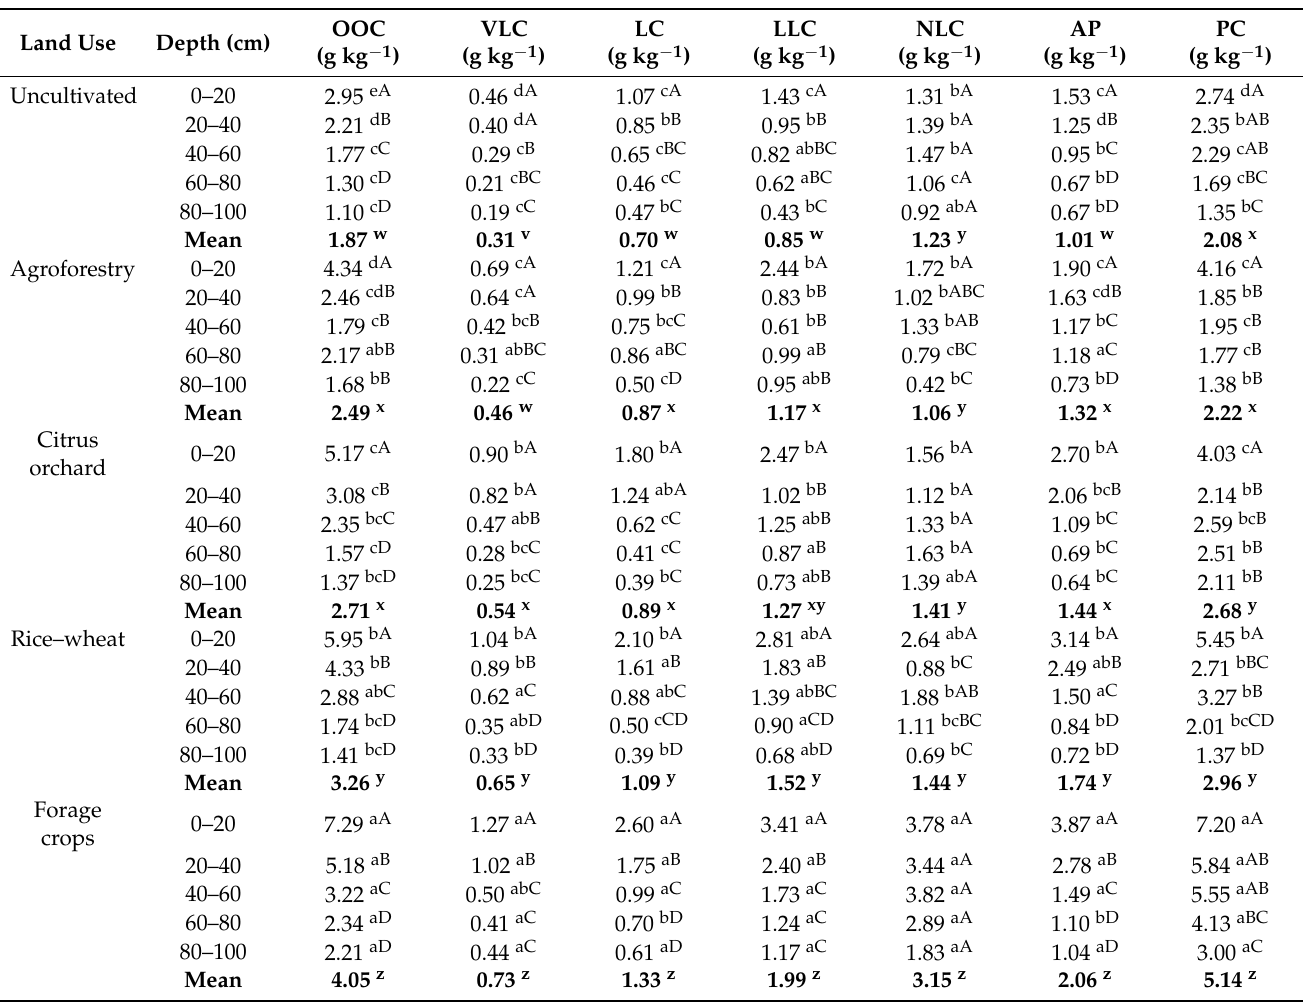
Table 4. In a hot, arid environment, the depth-wise distribution of oxidizable organic C (OOC) and its fractions as impacted by different land use